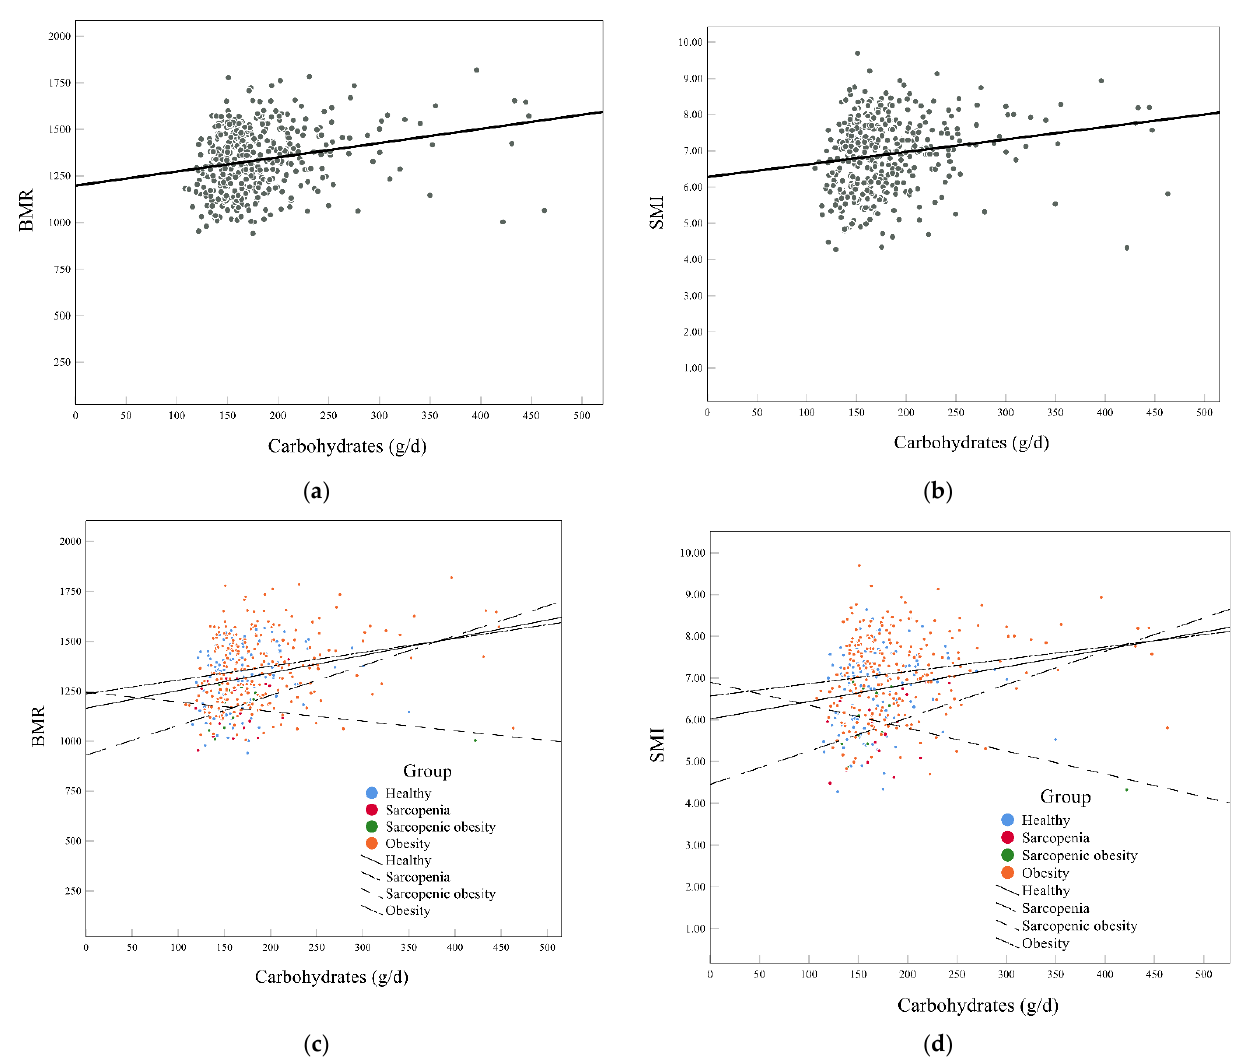
Figure 1. Associations of carbohydrates with BMR and SMI. ( a , c ) The association between carbohydrates and BMR in all subjects ( a ) and in different groups ( c ); ( b , d ) the association between carbohydrates and SMI in all subjects ( b ) and in different groups ( d ). BMR, basal metabolic rate; SMI, appendicular skeletal muscle index.